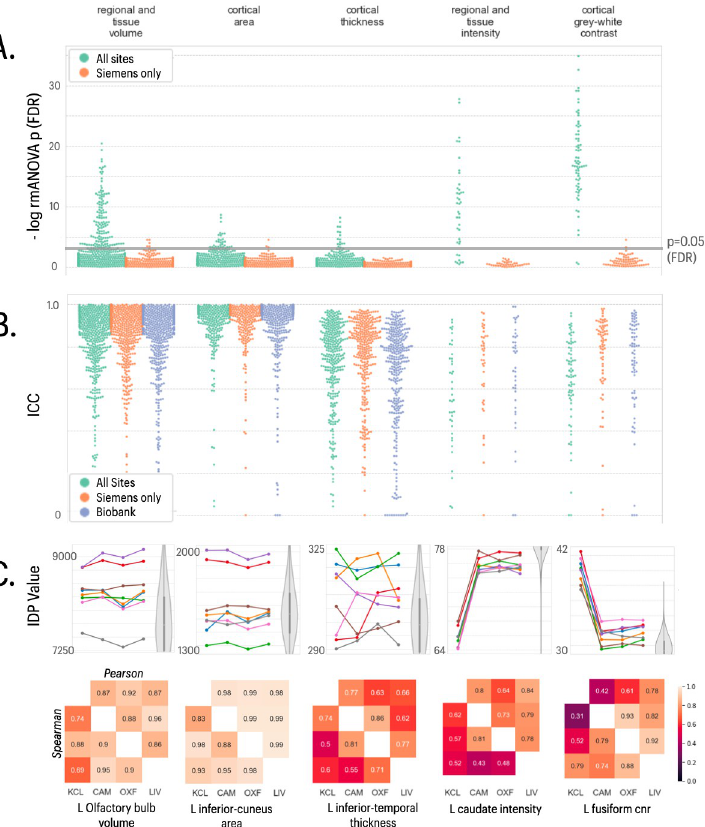
Fig 2. Statistical results for five classes of structural MRI-derived phenotypes. In the top two panels, each column represents results for a different class of IDP, from left to right: regional and tissue volumes, cortical area, cortical thickness, regional and tissue intensity, and cortical grey-white contrast. A) Distribution of log-transformed P -values from repeated measures ANOVA testing for a site effect on the mean value of individual IDPs in each class; the solid horizontal line represents the P -value equivalent to FDR = 5%. Green dots represent IDPs fitted to the ANOVA model including data from all four sites; orange dots represent P -values for each IDP fitted to the ANOVA including only data from the three Siemens sites (Cambridge, Oxford, Liverpool). There are more significant between-site differences in mean IDPs, across all 5 classes, when the GE data from KCL are included in the analysis B) Swarm plots showing distribution of intra-class correlation coefficients (ICCs) for the same IDPs, estimated for each pair of all 4 sites (green points), for each pair of the three Siemens sites (orange points), and for comparable test-retest data drawn from the UKB cohort (blue points). Between-site reliability was generally high for all IDP classes compared to the UKB benchmark, whether or not GE data were included in the analysis. C) Each column represents finer-grained results for representative IDPs from each class of IDP: from left to right, left olfactory bulb volume, left precuneus area, left inferior temporal cortical thickness, left caudate intensity and left fusiform CNR. Top row , plots of each IDP for 8 subjects (coloured lines) scanned at each of 4 sites (x-axis labels); the grey violin plots indicate the distributions of the corresponding IDP in the UK Biobank reference datase, using matched random sampling of N = 8 participants. Box and whiskers represent inter-quartile range and 95% confidence intervals respectively. Bottom row , correlations between each pair of sites for each IDP: upper triangle, Pearson’s correlations; lower triangle, Spearman’s correlations.